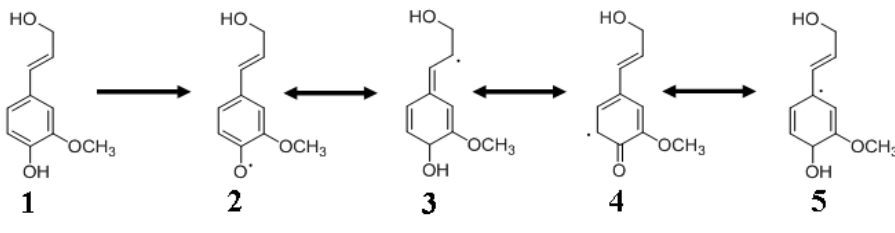
Figure 4. Coniferyl alcohol and its radicals. 1 , coniferyl alcohol; 2 and 4 are radicals; 3 and 5 are quinone methide radicals. First step is coniferyl alcohol radicalization by enzymatic